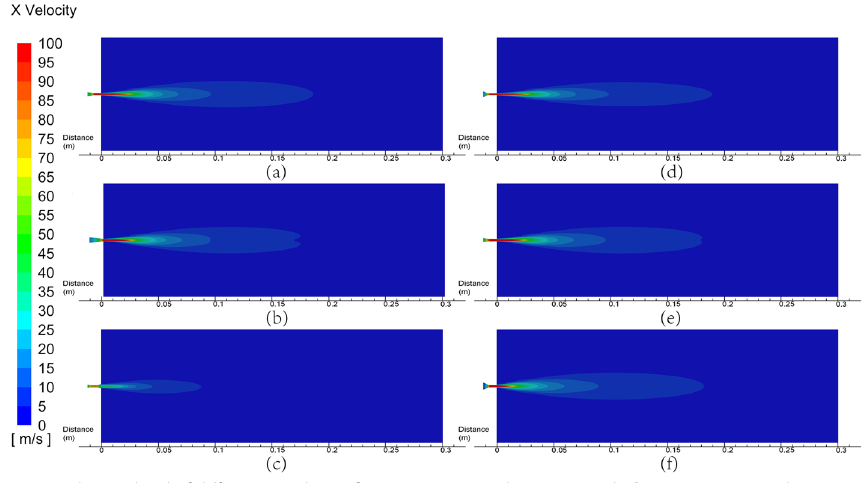
Fig. 8 Velocity cloud of different nozzle configurations. a Straight-taper nozzle. b Convergent nozzle. c Convergent-divergent nozzle. d Dual gradient nozzle. e Constant velocity gradient nozzle. f Streamline